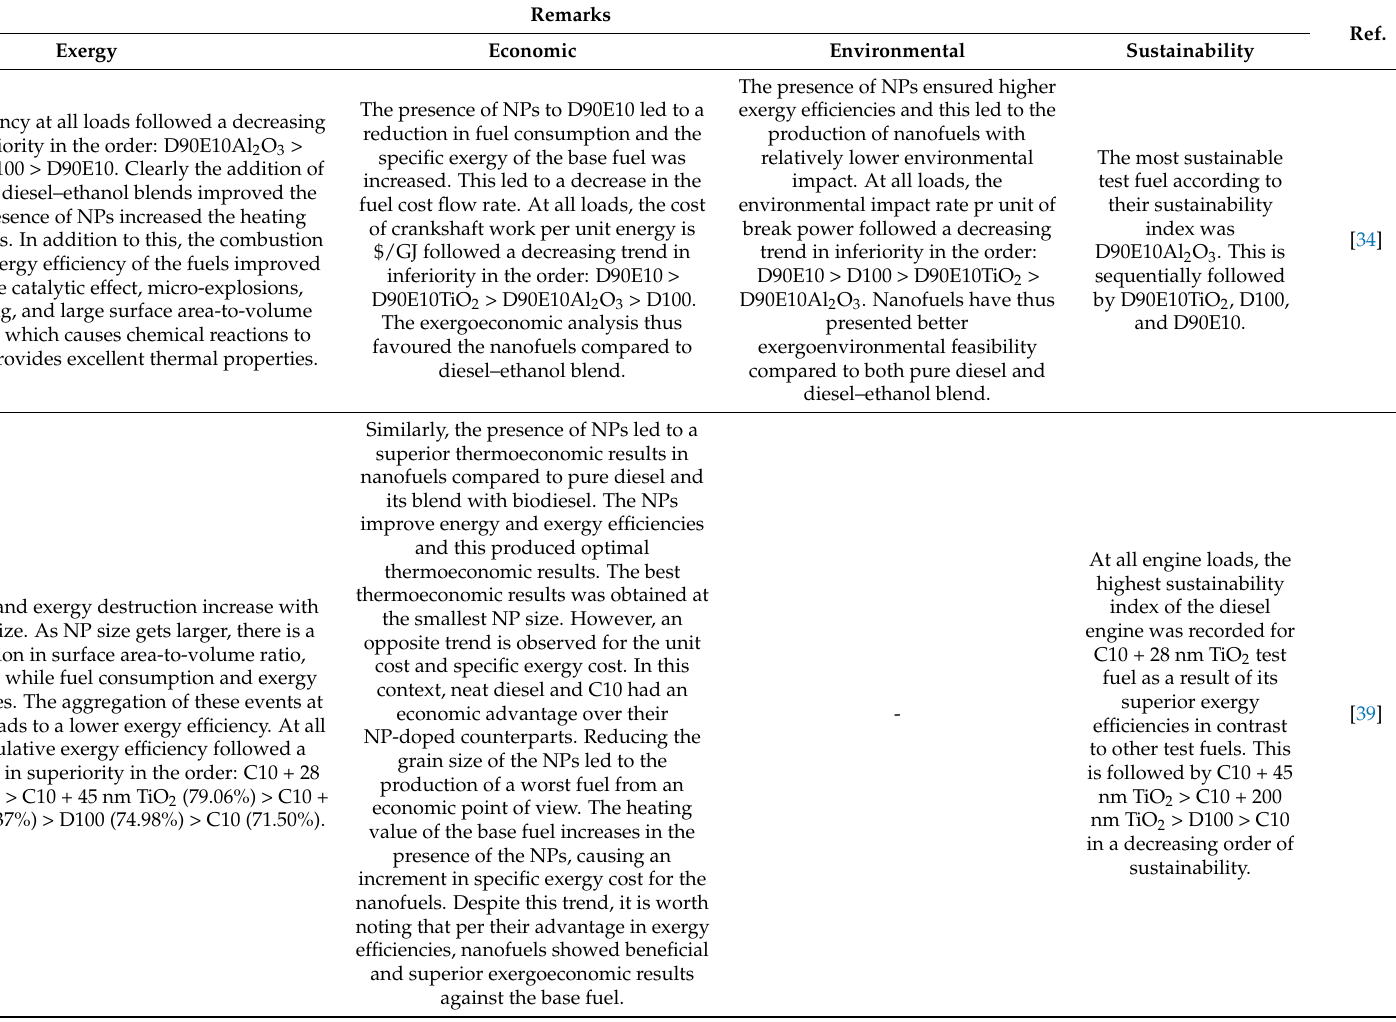
Table 7. Observations from exergy-based studies regarding low carbon fuels and nano-additives in diesel